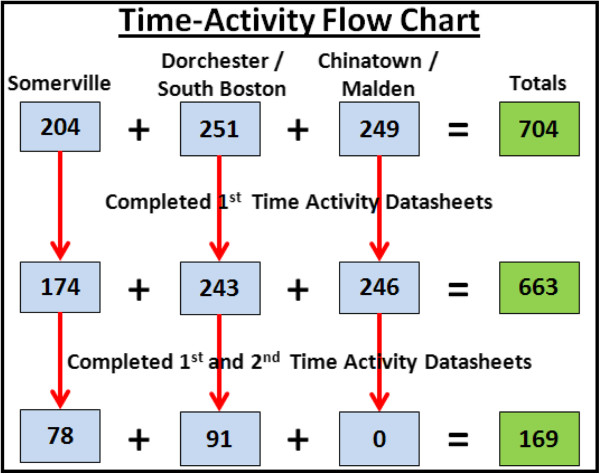
Micro-environment time-activity participant completion flow chart by study area.